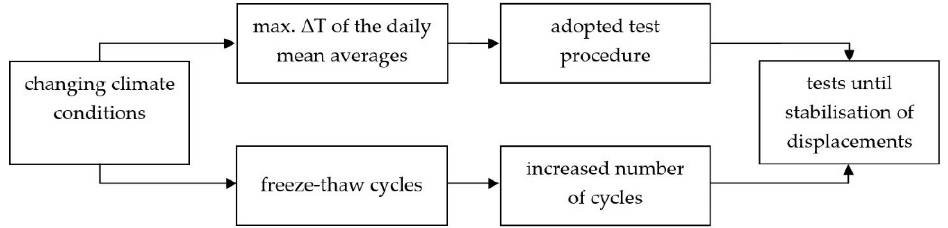
Figure 5. Schematic description of the approach, considering the real climate conditions for freeze- thaw testing.